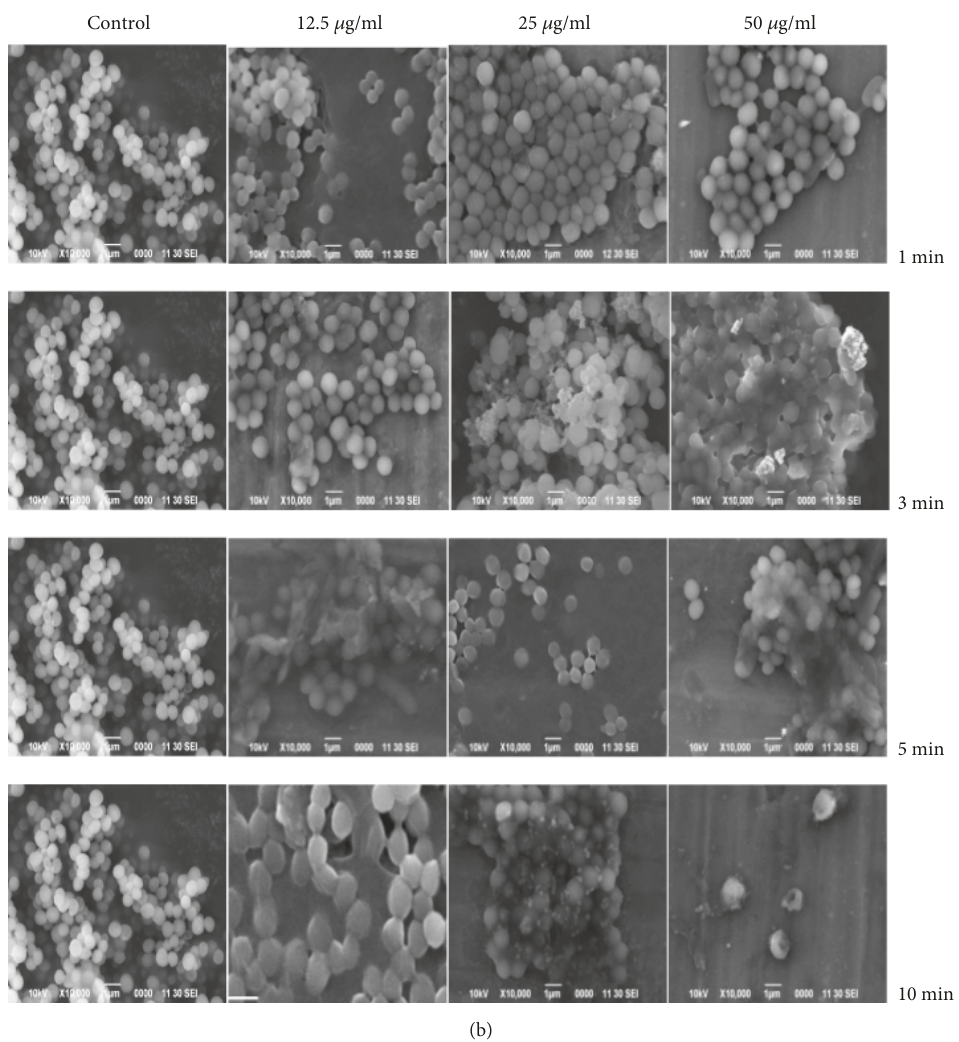
Figure 8: SEM images of (a) E. coli and (b) S. aureus bacterial cells. The images correspond to the control group without treatment and bacterial cells treated with 50, 25, and 12.5 μ g/m Ag-NPs photoactivated at di ff erent exposure times of 1, 3, 5, and